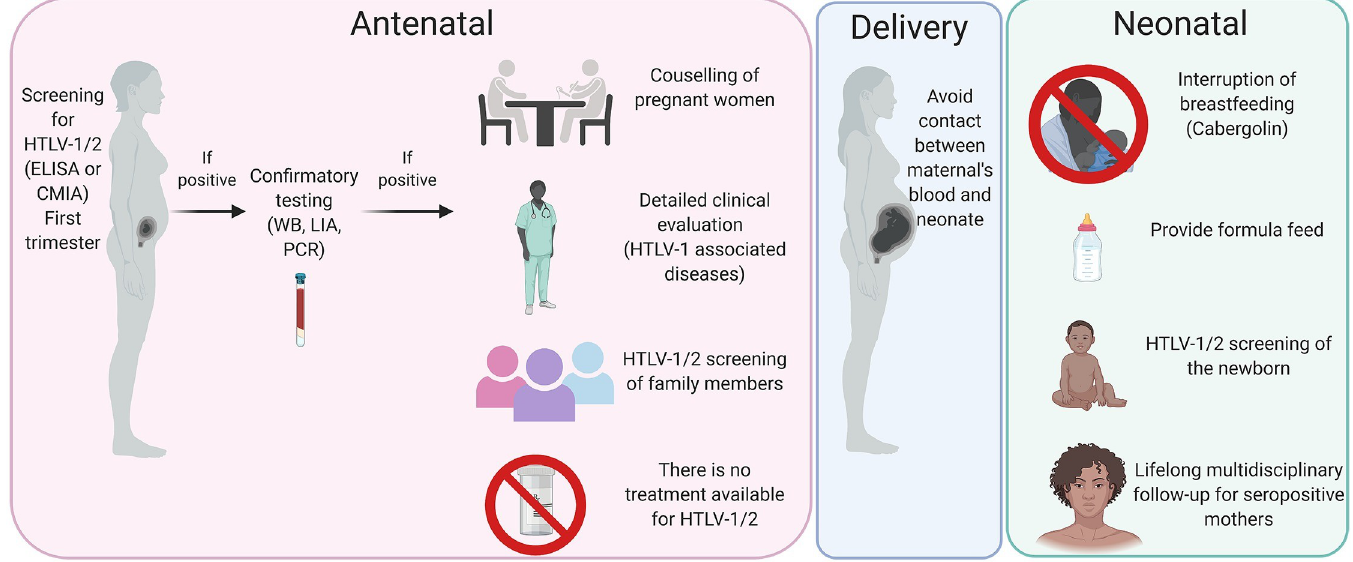
Fig 1. Flowchart proposal for management of HTLV-1/2 infection in pregnant women and prevention of mother-to-child transmission. C AU : AnabbreviationlisthasbeencompiledforthoseusedthroughoutFig 1 : Pleaseverifythatallentriesarecorrect : MIA, chemiluminescence assay; HTLV-1/2, human T-cell lymphotropic virus 1 and 2; LIA, line immunoassay; WB, western blot.